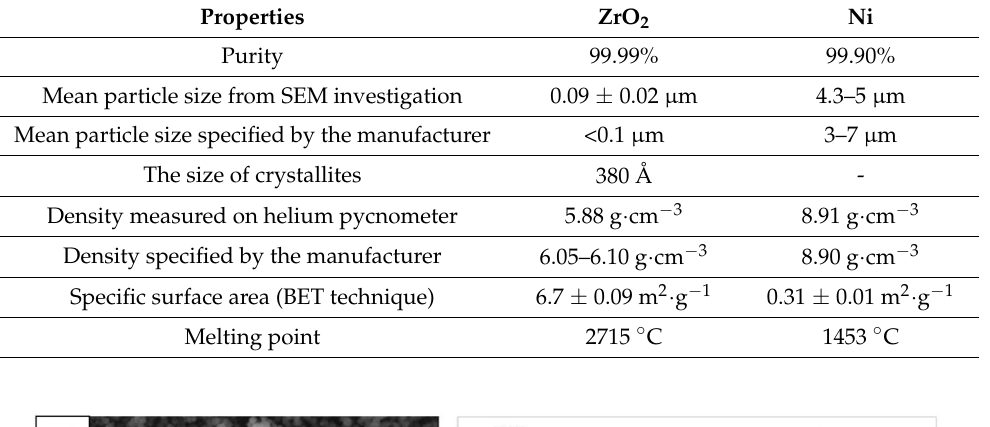
Table 1. Properties of the raw powders.